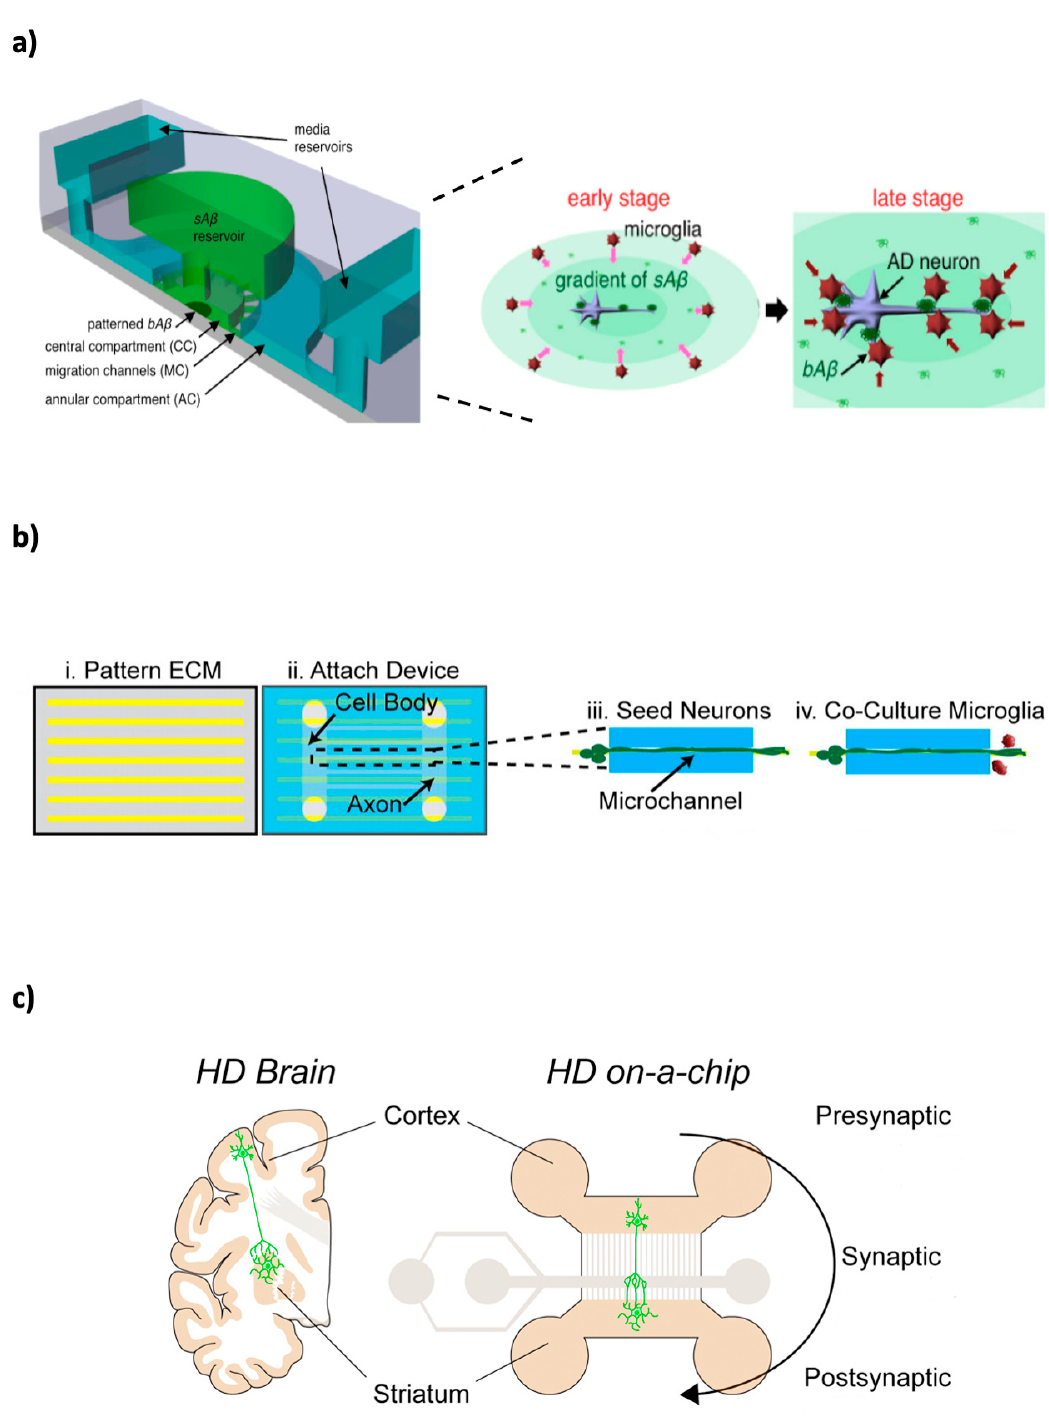
Figure 5. Schematic representation of some microfluidic models for neurodegenerative diseases, namely: ( a ) Alzheimer’s disease, ( b ) Multiple sclerosis, ( c ) Huntington’s disease. Reprinted and adapted with permission from: ( a ) Cho et al. [88], ( b ) Hosmane et al. [105], ( c ) Virlogeux et al. [113].